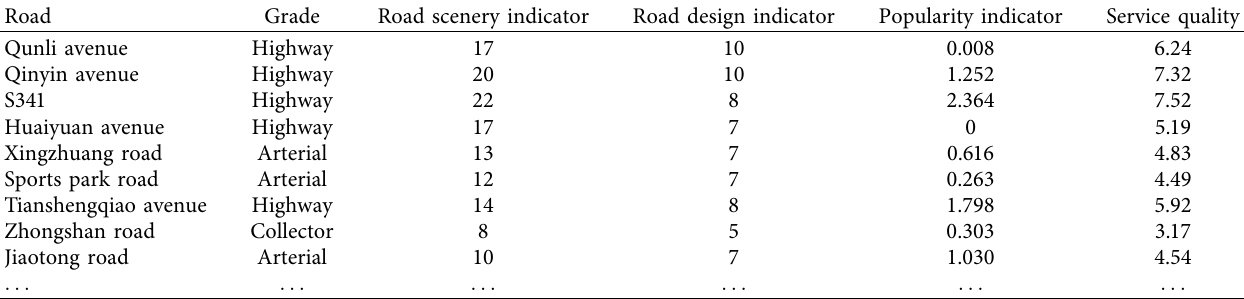
Table 4: Examples of the evaluated quality of service on diferent roads in the Lishui district. Road